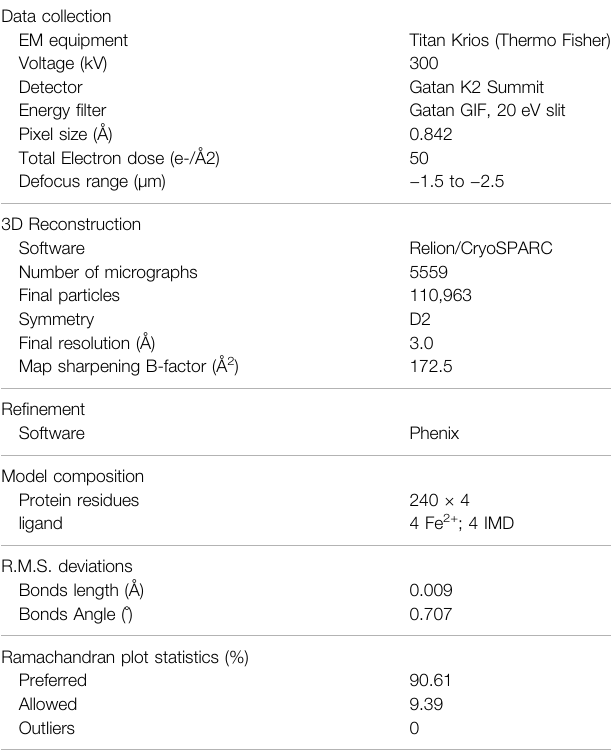
TABLE 1 | Summary of data collection, processing, and atom model